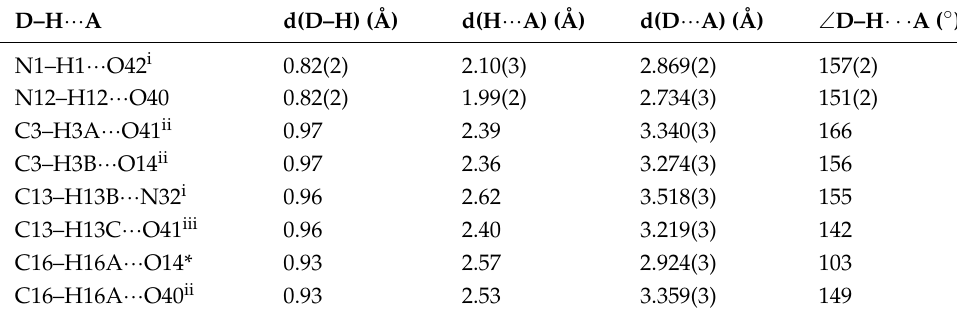
Table 3. Hydrogen bond geometry for saccharin salt of chlordiazepoxide.